Question: Provide a one-line summary of what is displayed.
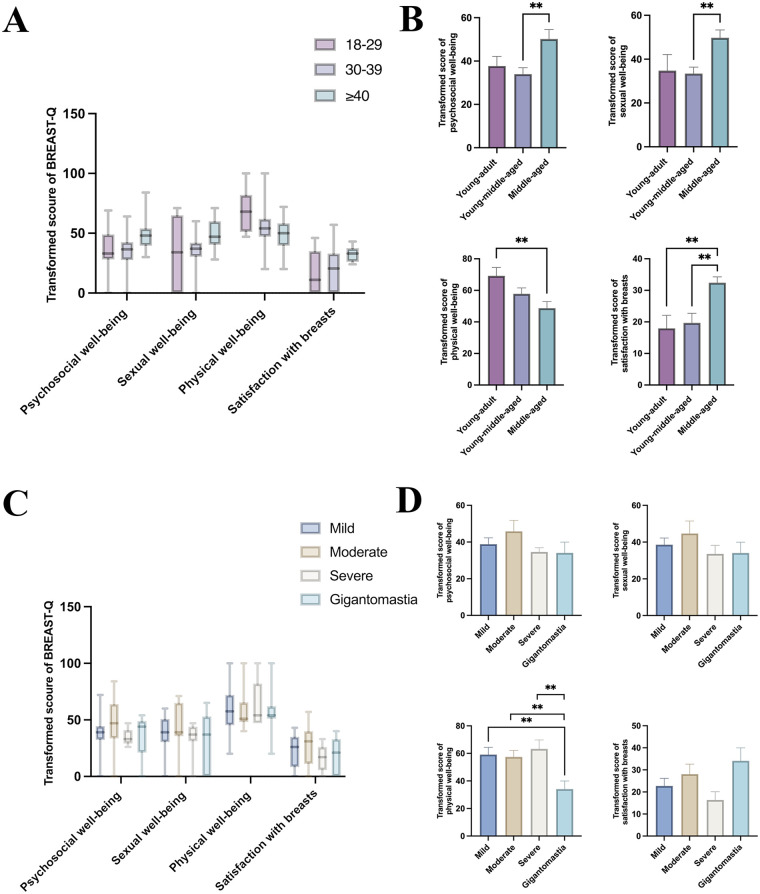
Answer: Associations of age and macromastia severity with BREAST-Q outcomes. (A) Box plots showing the distribution of transformed BREAST-Q scores across age groups; (B) Comparison of transformed BREAST-Q scores among age groups by one-way ANOVA; (C) Box plots showing the distribution of transformed BREAST-Q scores across volumetric macromastia categories; (D) Comparison of transformed BREAST-Q scores among volumetric macromastia categories by one-way ANOVA. Statistical significance: ** P < 0.01.